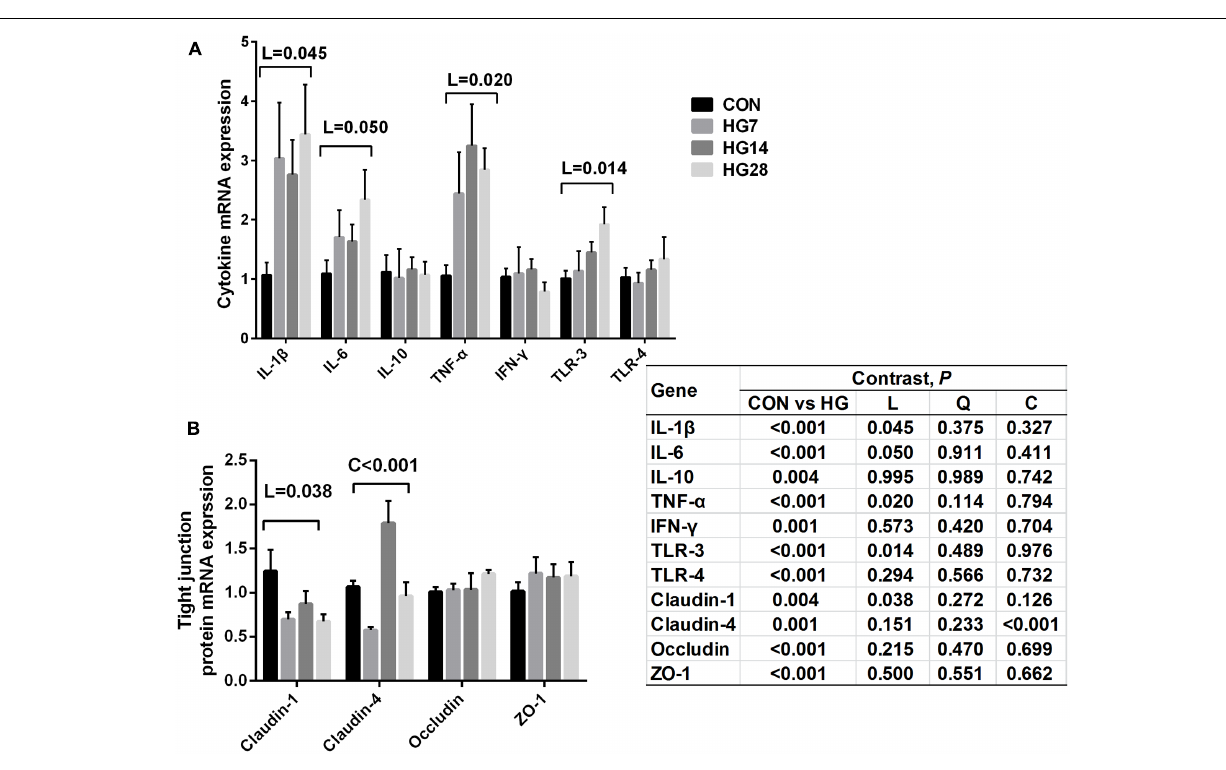
Frontiers in Microbiology |